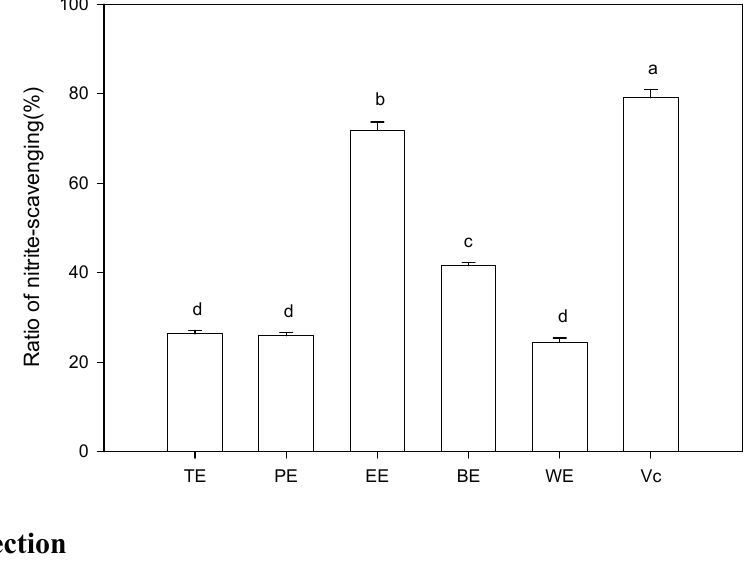
Figure 4. Nitrite-scavenging capacity of different extracts of sugarcane tops. TE, PE, EE, BE, and WE were the abbreviations of total extract, petroleum ether extract, EtOAc extract, n -BuOH extract, and water extract, respectively. Different letters horizontally (a–d) indicated signi fi cant differences ( p < 0.05) of nitrite-scavenging capacity among different extracts according to Duncan’s multiple range